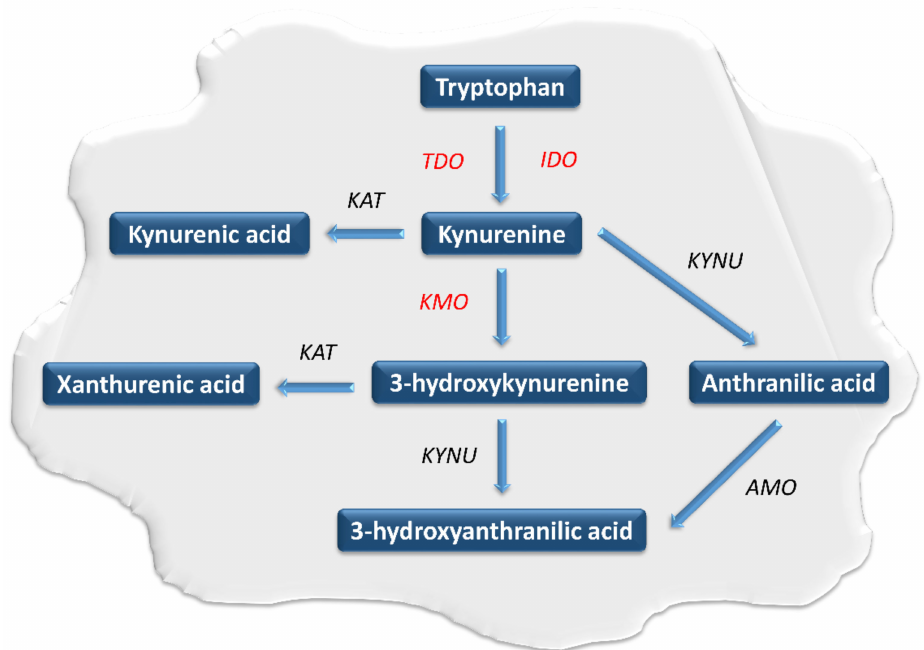
Figure 1. The course of the kynurenine pathway in neoplastic cells. The kynurenine pathway enzymes are in italics, while those involved in carcinogenesis are marked in red. AMO: aminocar- boxymuconatesemialdehyde decarboxylase, IDO: indoleamine 2,3-dioxygenase, KAT: kynurenine aminotransferase, KMO: kynurenine 3-monooxygenase, KYN: kynurenine, KYNU: kynureninase, TDO: tryptophan